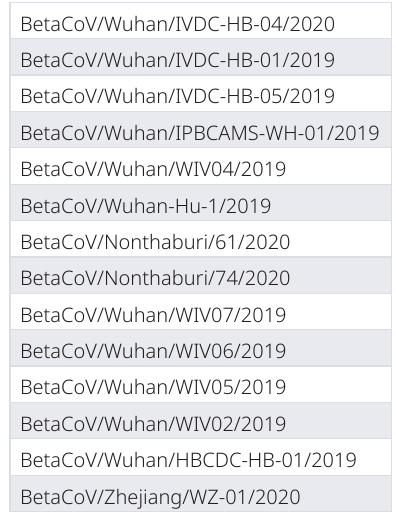
Table 2. S1 proteins from SARS-CoV-2 (GISAID).